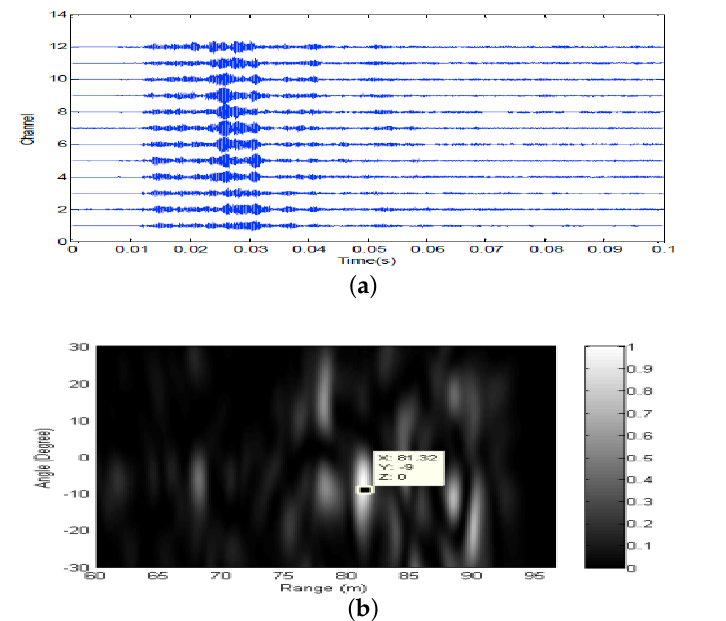
Figure 19. LFM signals: ( a ) the enhanced echoes received by the 14-element horizontal array; ( b ) the ambiguity surface of the output of the distributed TR-MIMO sonar system.